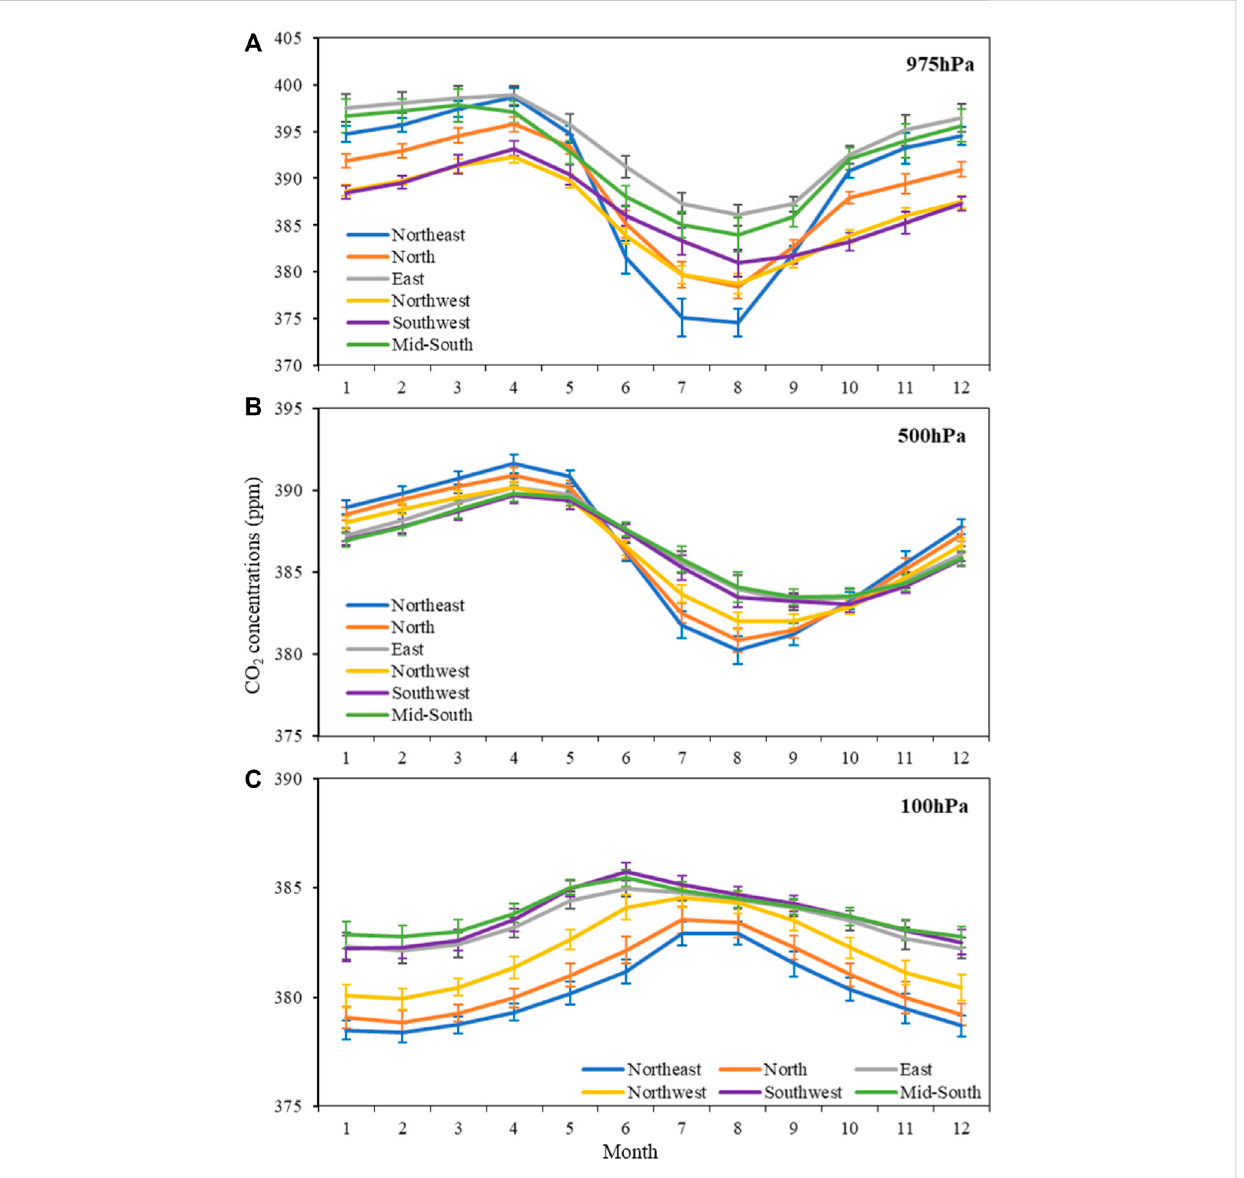
FIGURE 5 Monthly means of CO 2 for the three typical layers over the period 2009 –